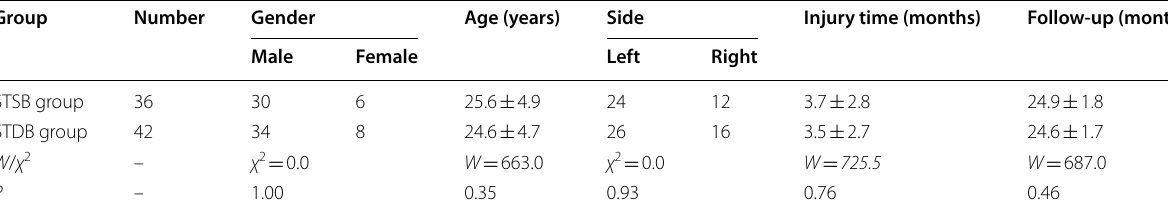
Note: the independent-samples t -test and χ 2 test were used